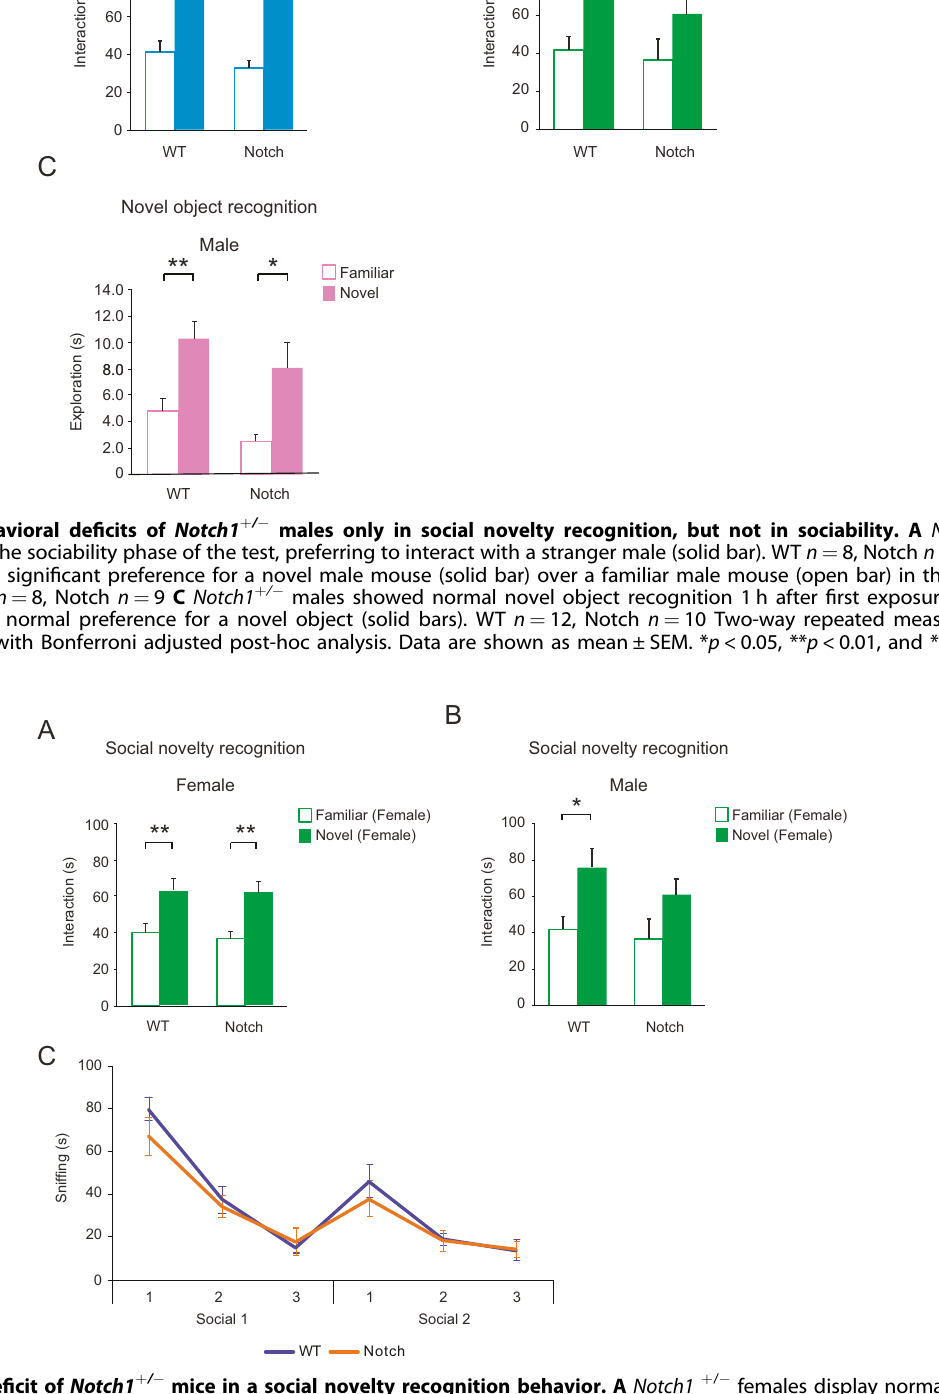
Fig. 2 Sex speci fi c de fi cit of Notch1 + / − mice in a social novelty recognition behavior. A Notch1 + / − females display normal preference for novel female strangers (solid bar) in the social novelty recognition test. WT n = 12, Notch n = 16 B Notch1 + / − males are also impaired in social recognition towards female strangers (solid bar). WT n = 20, Notch n = 13 C Notch1 + / − males showed normal habituation and dishabituation to social odors. There was no difference between WT (purple) and Notch (orange) in any of the 6 trials. WT n = 10, Notch n = 8. Two-way repeated measures analysis of variance (rmANOVA) with Bonferroni adjusted post-hoc analysis. Data are shown as mean ± SEM. * p < 0.05 and ** p <